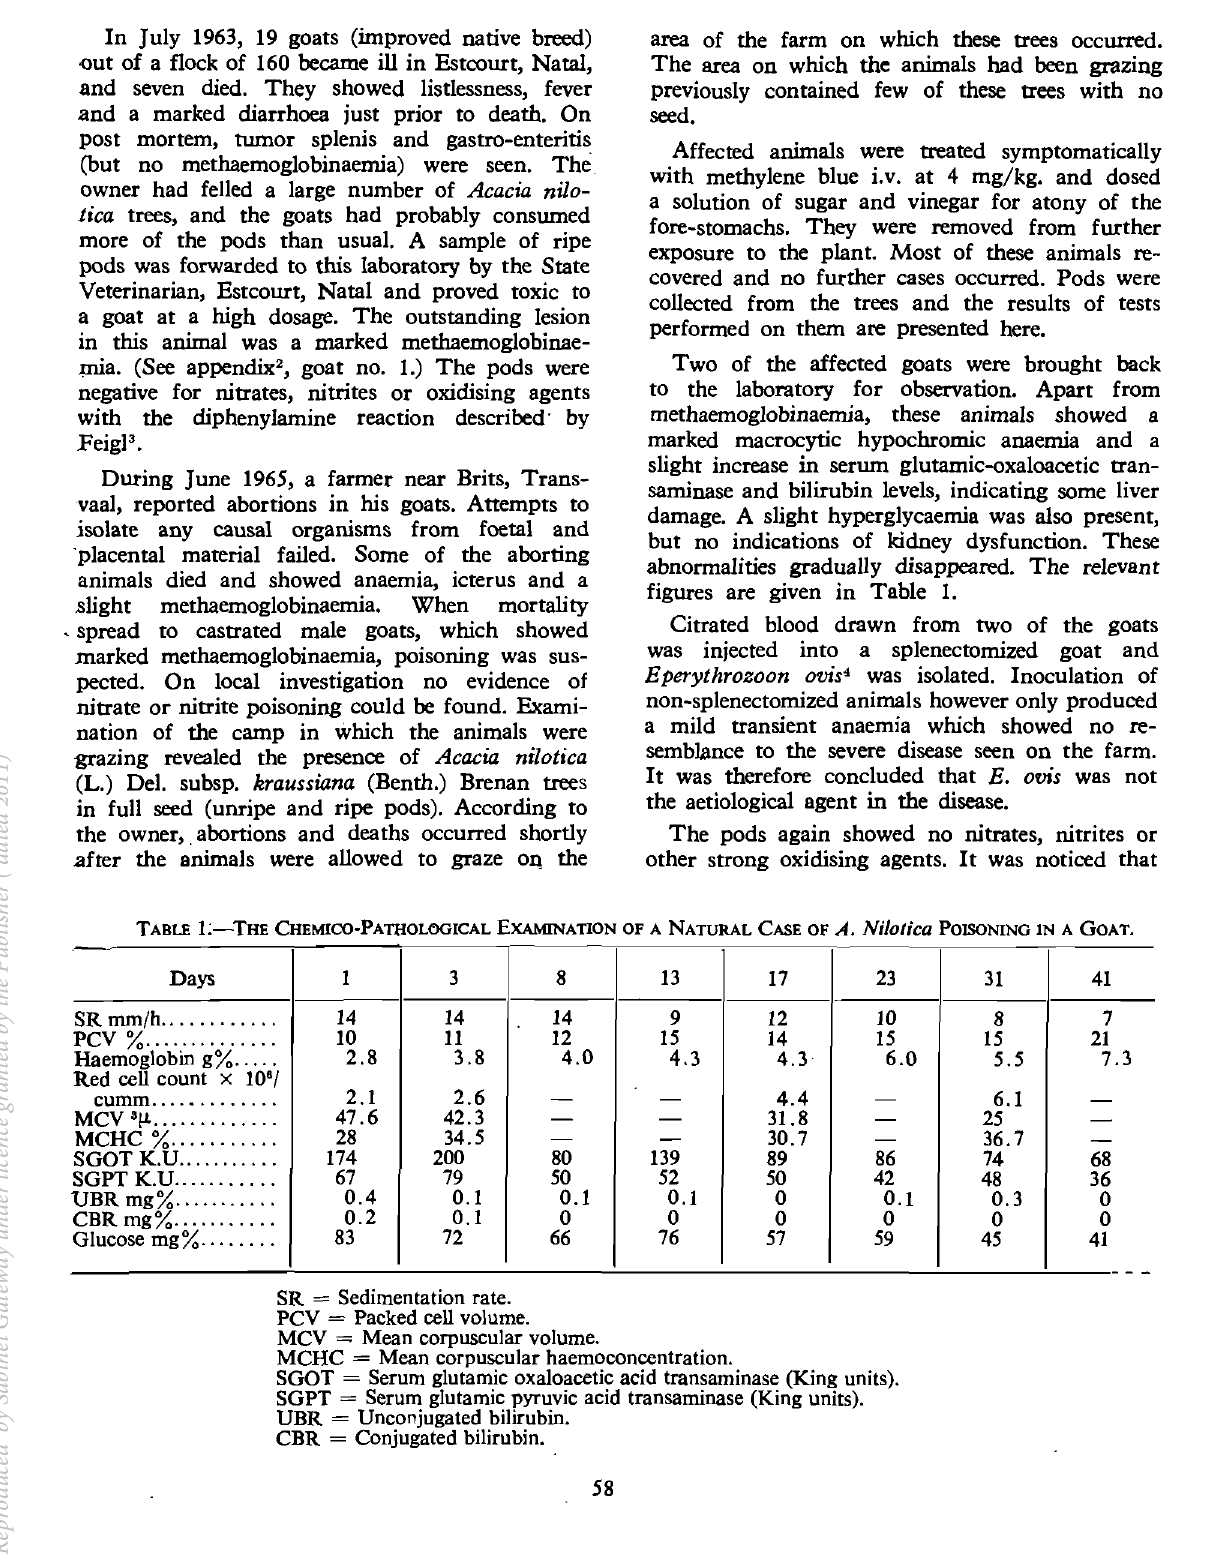
UBR = Unconjugated bilirubin. CBR = Conjugated